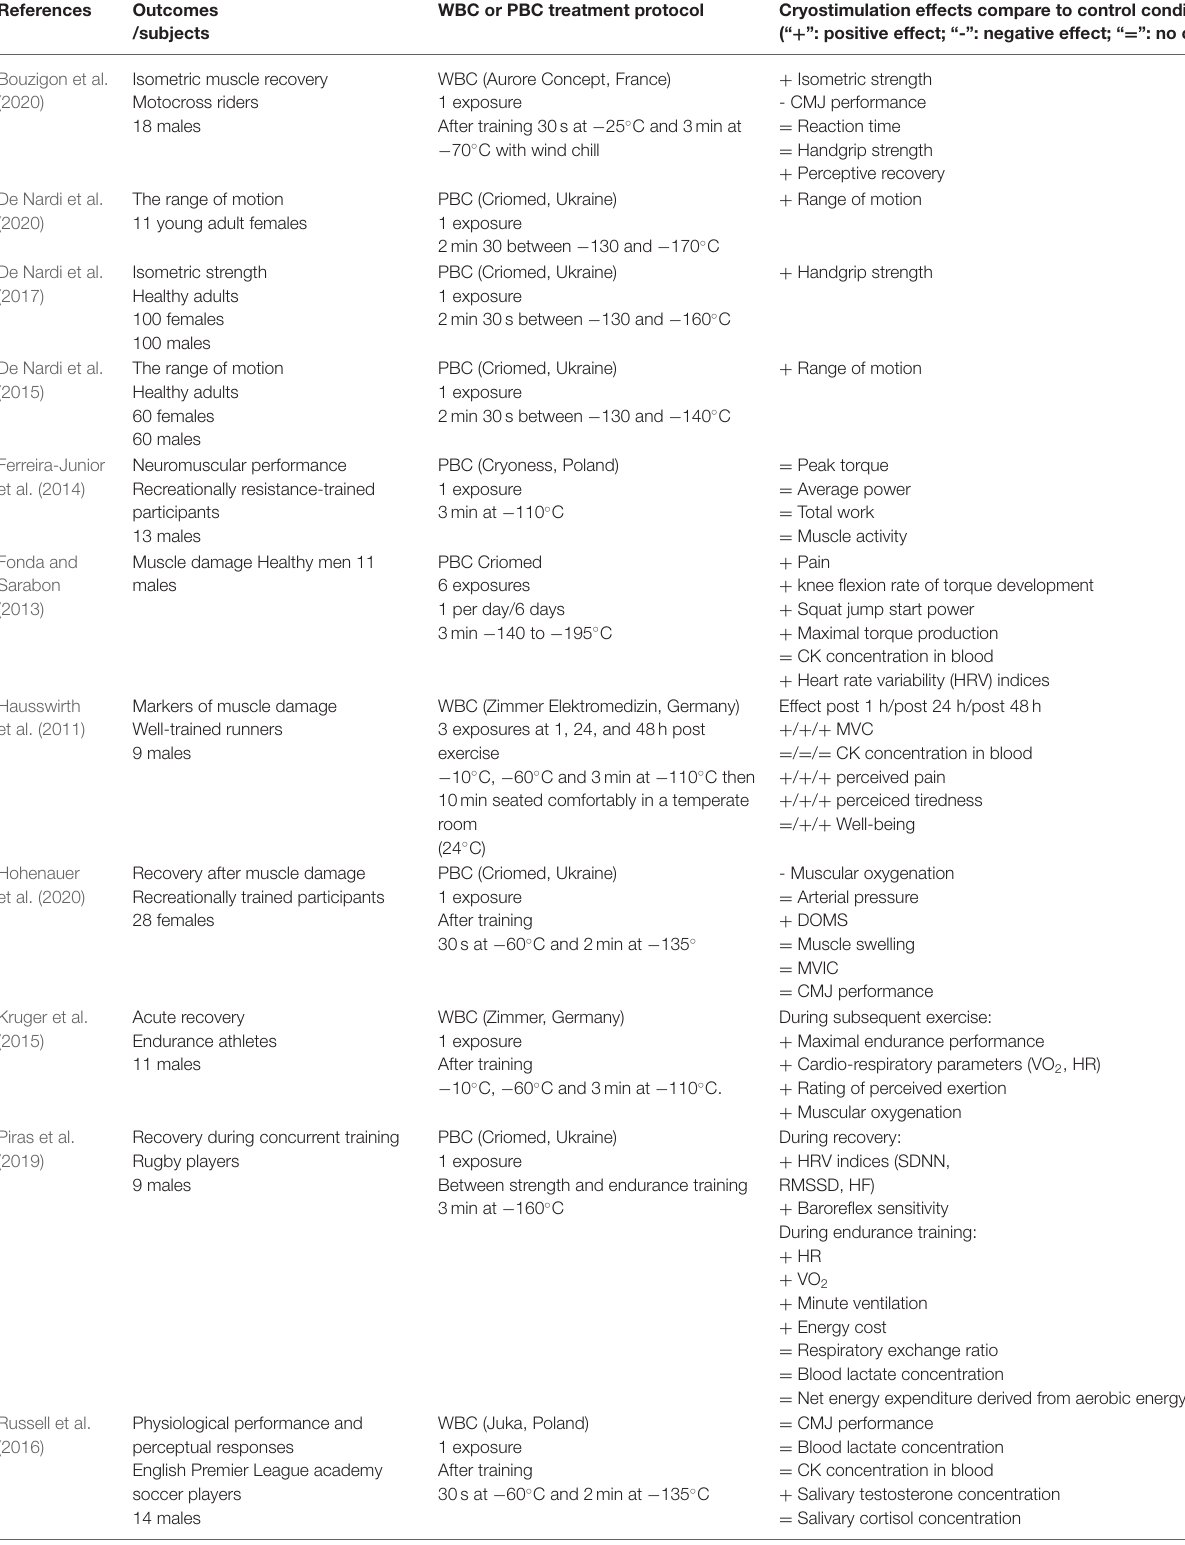
TABLE 1 | The studies investigating the acute effects of cryostimulation on the physical